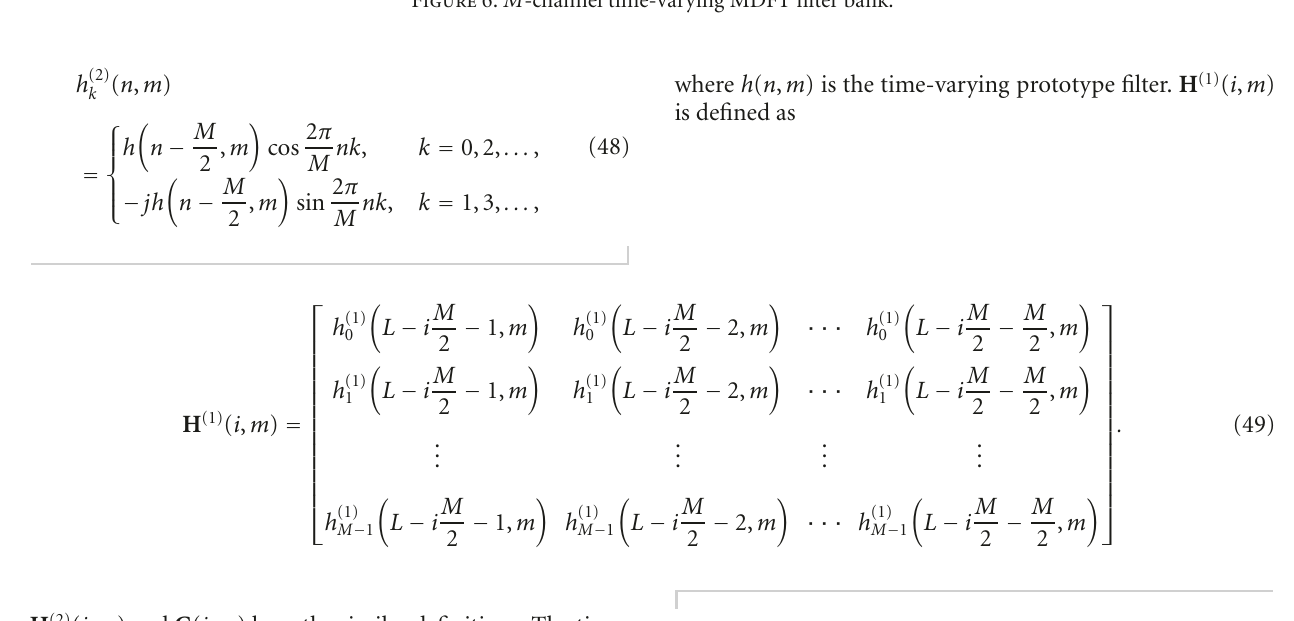
Figure 6: M -channel time-varying MDFT filter